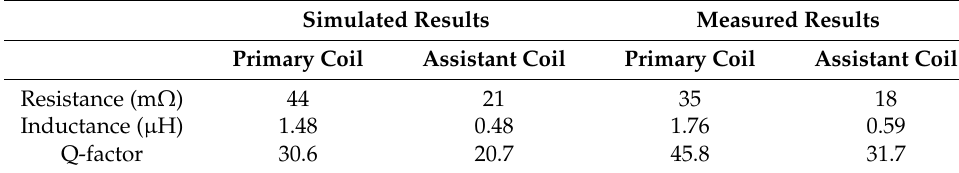
Table 3. Simulated and measured electrical parameters of designed coils.